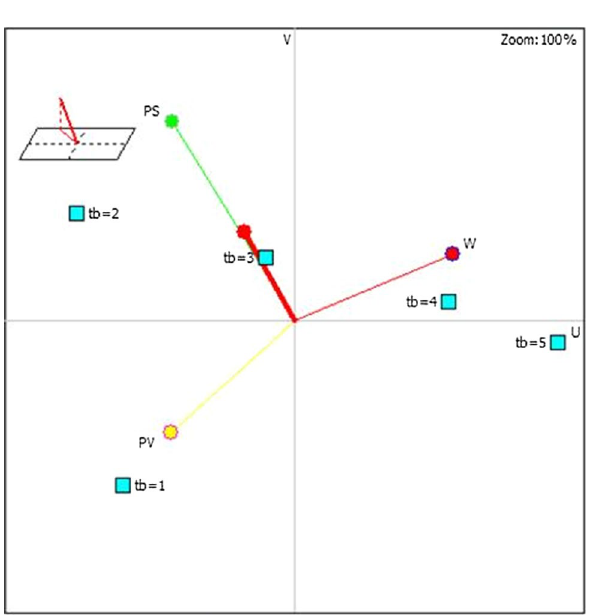
Fig. 9 Results obtained by using the method GAIA